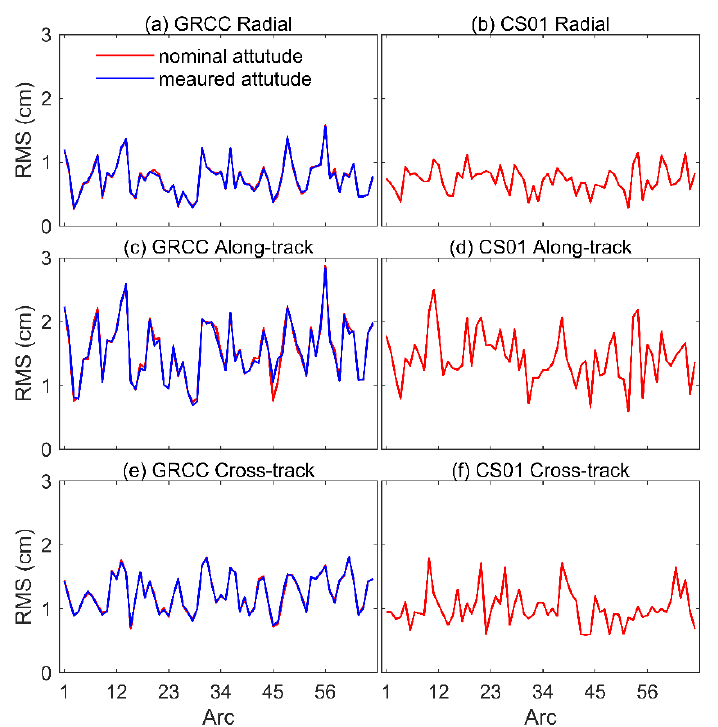
Figure 4. The difference in phase center vectors in CTS frame using nominal and measured attitude. DOY 273, 2018.